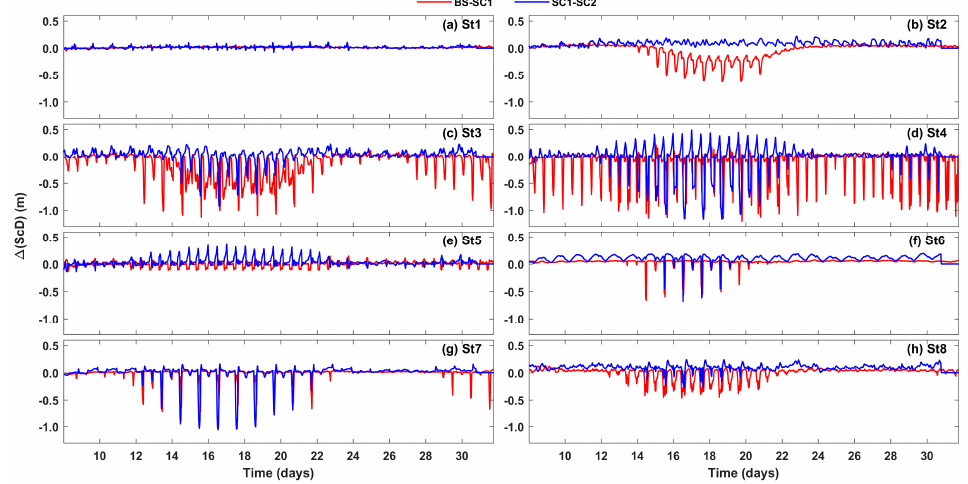
Figure 12. Time series of the Secchi depth, ScD, for the scenarios, BS, SC1 and SC2, for September 2000, and the lagoon stations : ( a ) St1, ( b ) St2, ( c ) St3, ( d ) St4, ( e ) St5, ( f ) St6, ( g ) St7 and ( h ) St8.